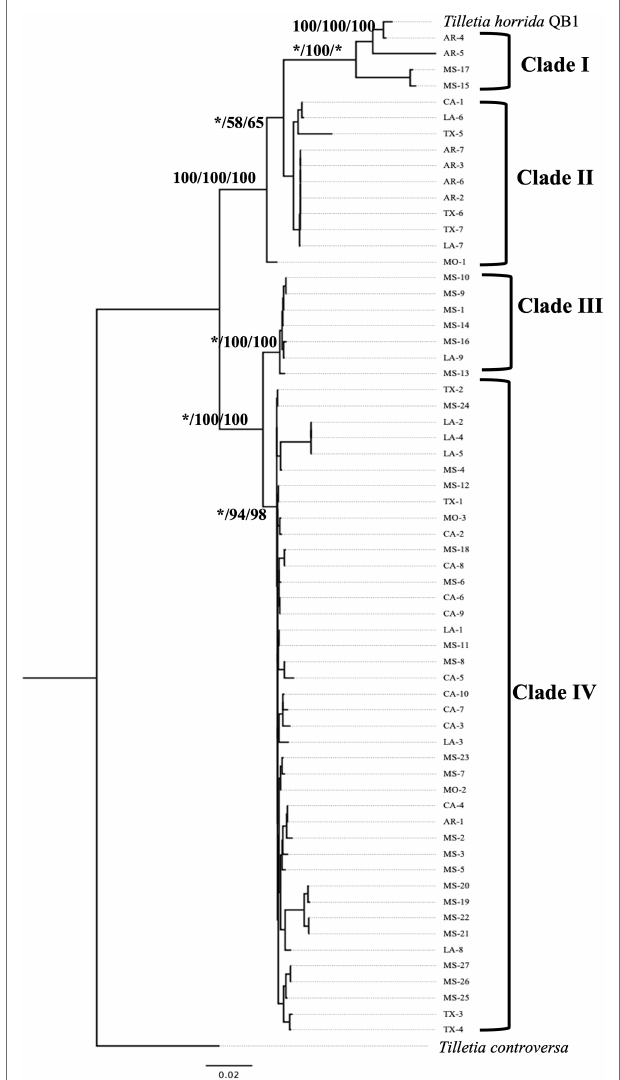
FIGURE 3 | Neighbor-joining phylogenetic tree of concatenated sequences with EF -1 α , RPB1 , LSU, and ITS of 63 isolates collected from Arkansas (AR), California (CA), Louisiana (LA), Mississippi (MS), Missouri (MO), and Texas (TX) in the US. T. horrida strain QB1 was used as a reference isolate and T. controversa strain DAOMC 236426 was used as an outgroup. The scale bar represents the number of substitutions per site. The value on the branches indicates the percentage of trees based on 1,000 bootstrap replicates on ML/NJ/ME, respectively. Only branches values with >50% replicates are show; “*” indicates that the branch value is less than 50%.